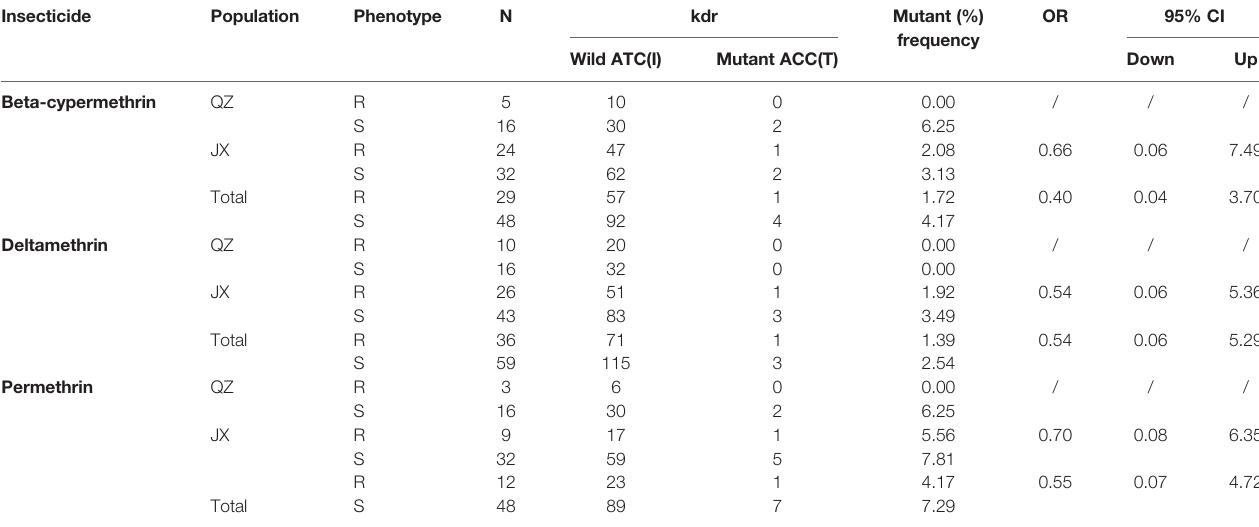
TABLE 3 | Kdr mutant allele frequency at codon 1532 of Ae . albopictus populations in QZ and JX.